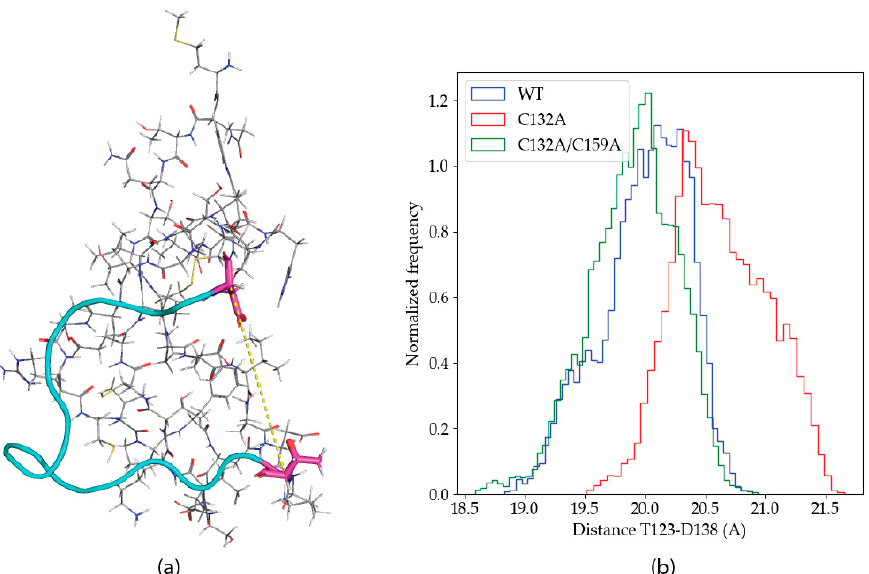
Figure 6. ( a ) Angular conformation of the 122–151 subsequence, in cyan, and the T123 (down) and D138 residues, in magenta. The distance between the respective alpha carbons is shown as a yellow dashed line. ( b ) Histogram of the T123-D138 distances for the aggregated wild type, C132A and C132A/C159A trajectories.